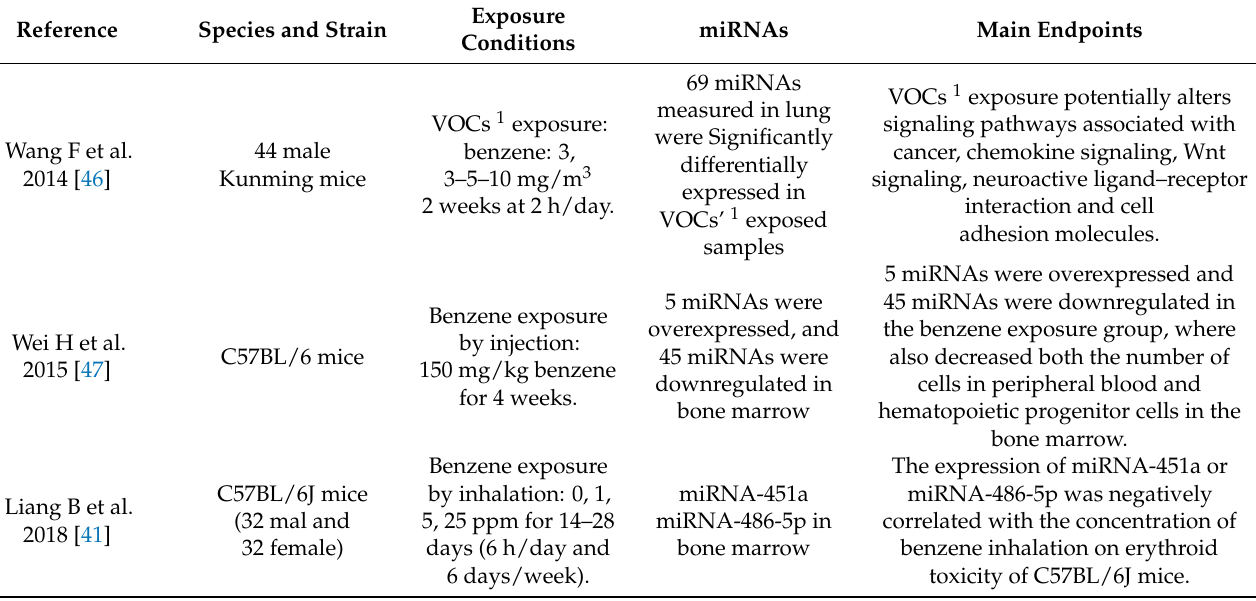
Table 2. The main outcomes from in vivo